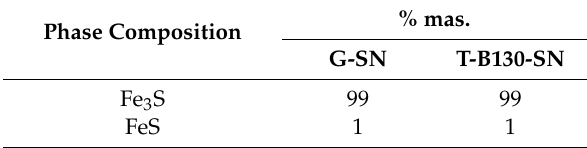
Table 5. Phase composition in the SL of Vanadis 8 tool steel after: G-SN and T-B130-SN.